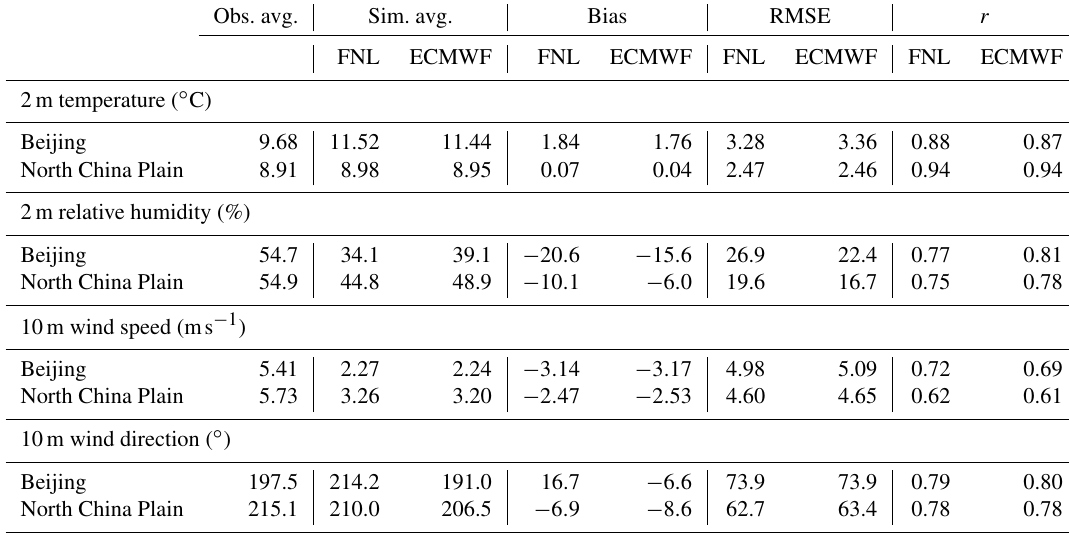
Table 2. Comparison of observed and simulated meteorological variables using FNL and ECMWF fields. Obs. avg. Sim. avg. Bias RMSE r FNL ECMWF FNL ECMWF FNL ECMWF FNL